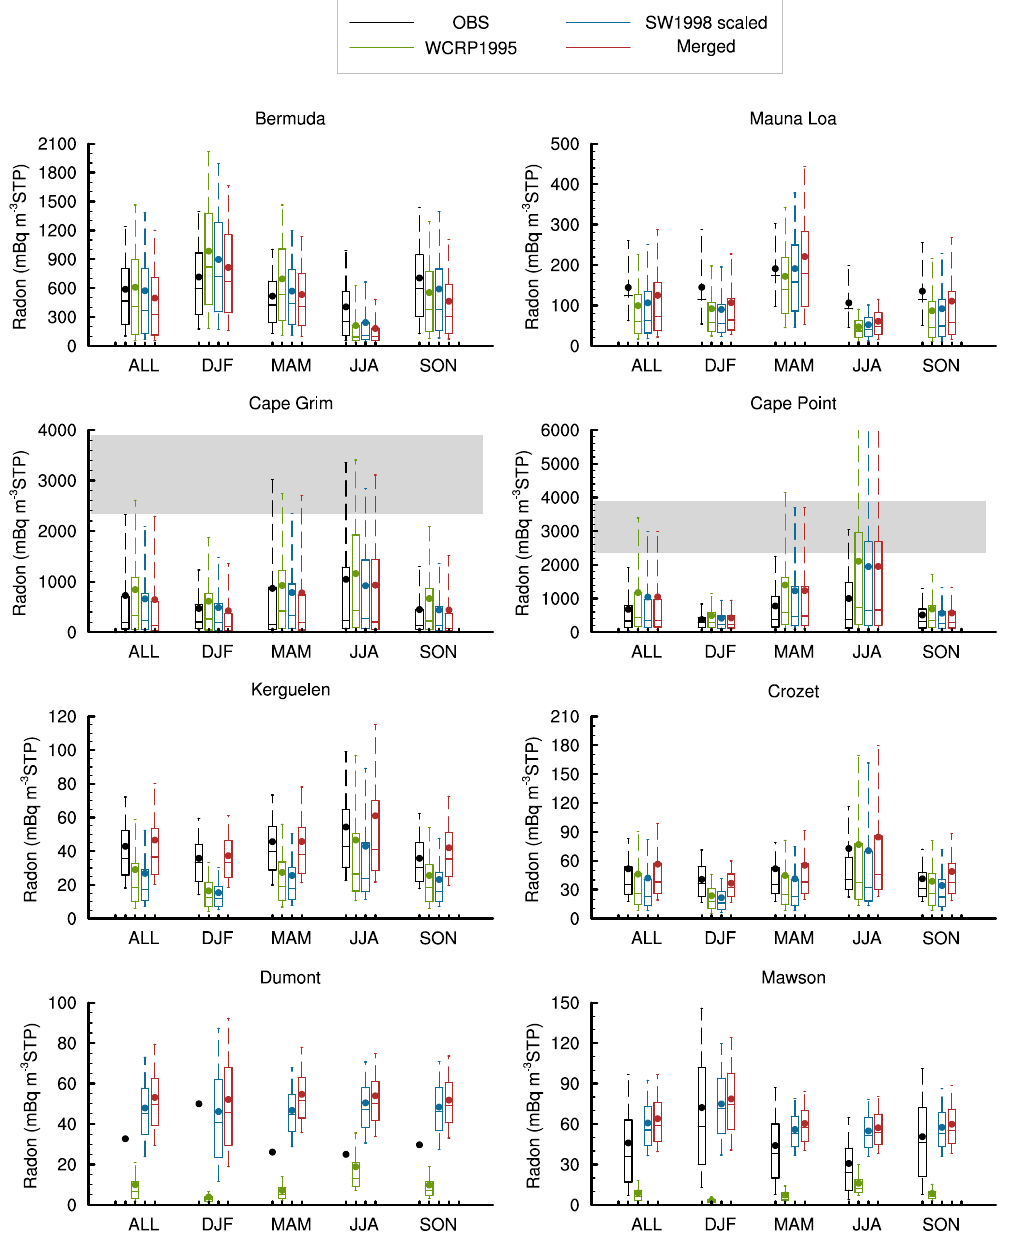
Fig. 10. Same as Fig. 7 but for coastal and oceanic sites. Most panels in this figure do not have a gray box in them because at these sites the radon family induces much less ionizing energy than the cosmic rays. The gray box is therefore literally off the chart.